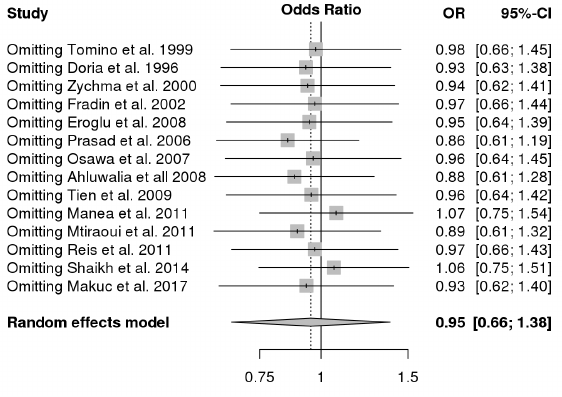
Figure 3 . Sensitivity analysis results for the AGT M235T polymorphism and DN (dominant model).